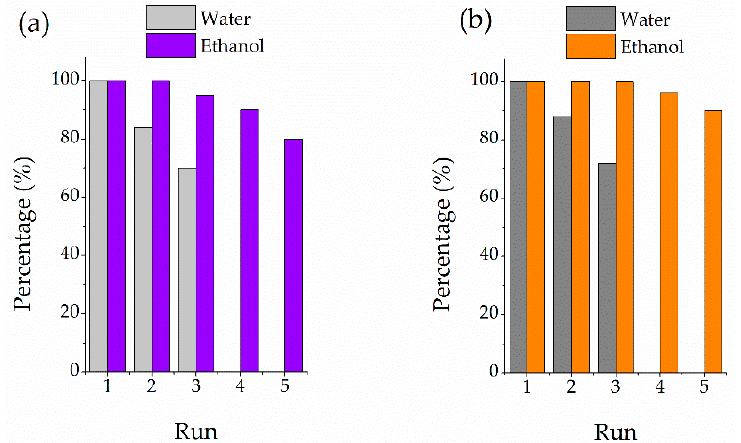
Figure 8. Recycling studies in the hydrogenation of ( a ) NFMF and ( b ) NFMO at 180 min of reaction using water and ethanol as solvent.